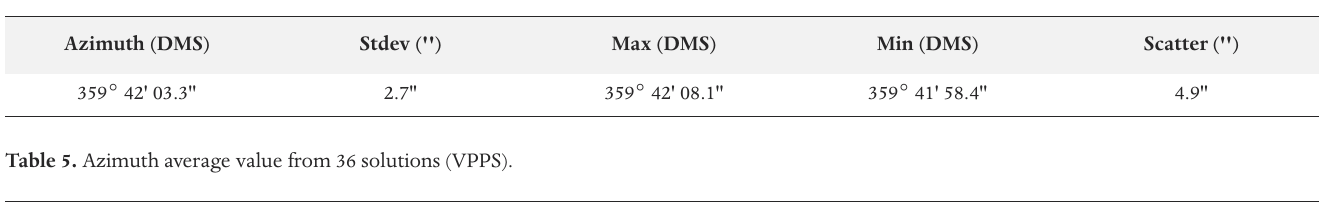
Table 4. Ellipsoidal coordinates and their precision